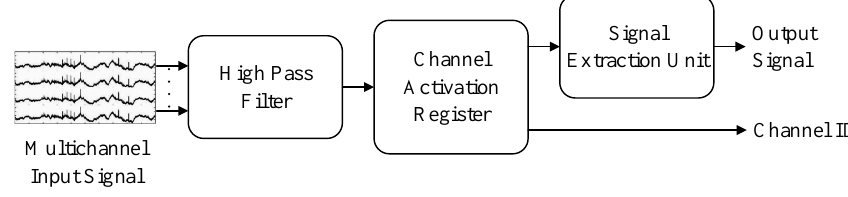
Figure 1. Simplified block diagram of the proposed